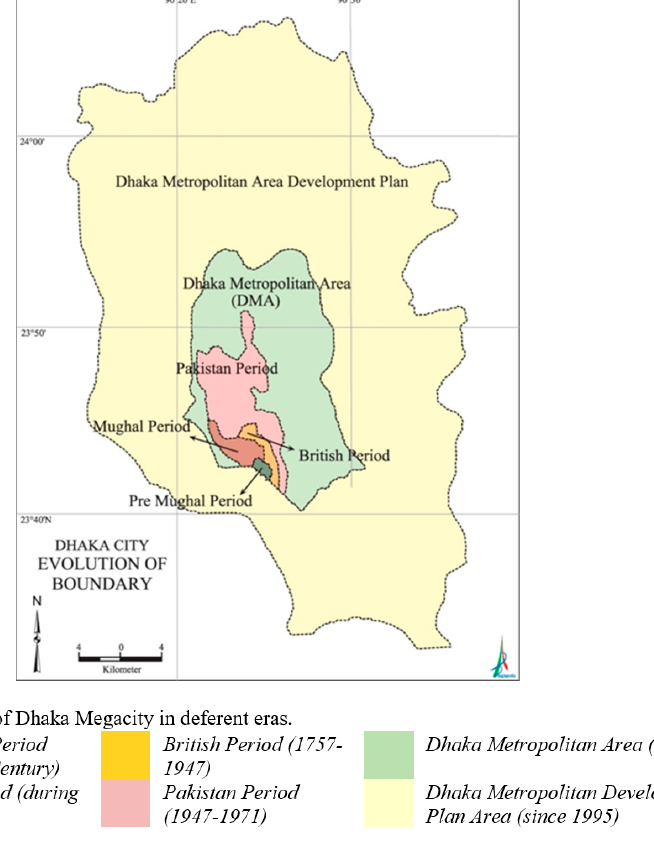
Figure 2. Historical, administrative and planning boundaries of Dhaka city [13].